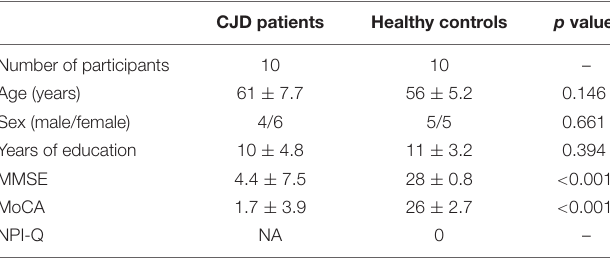
TABLE 2 | Demographic data of patients with Creutzfeldt–Jacob disease (CJD) and healthy controls.